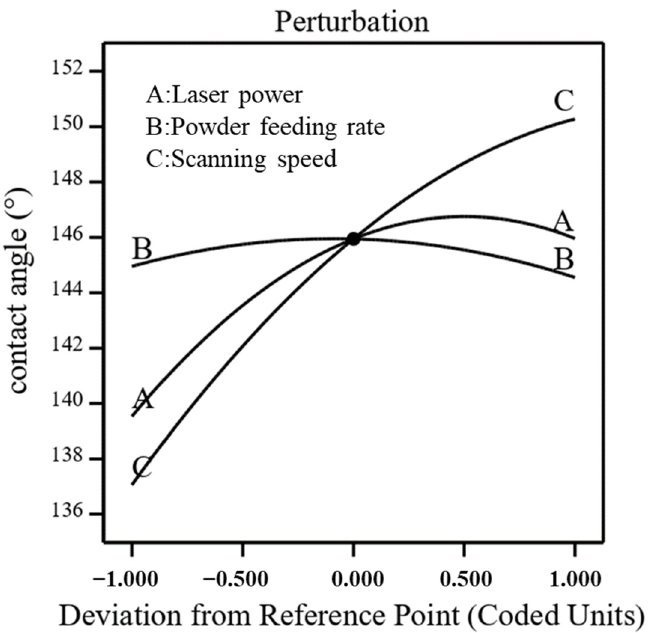
Figure 10. Perturbation of three process parameters to the contact angle.